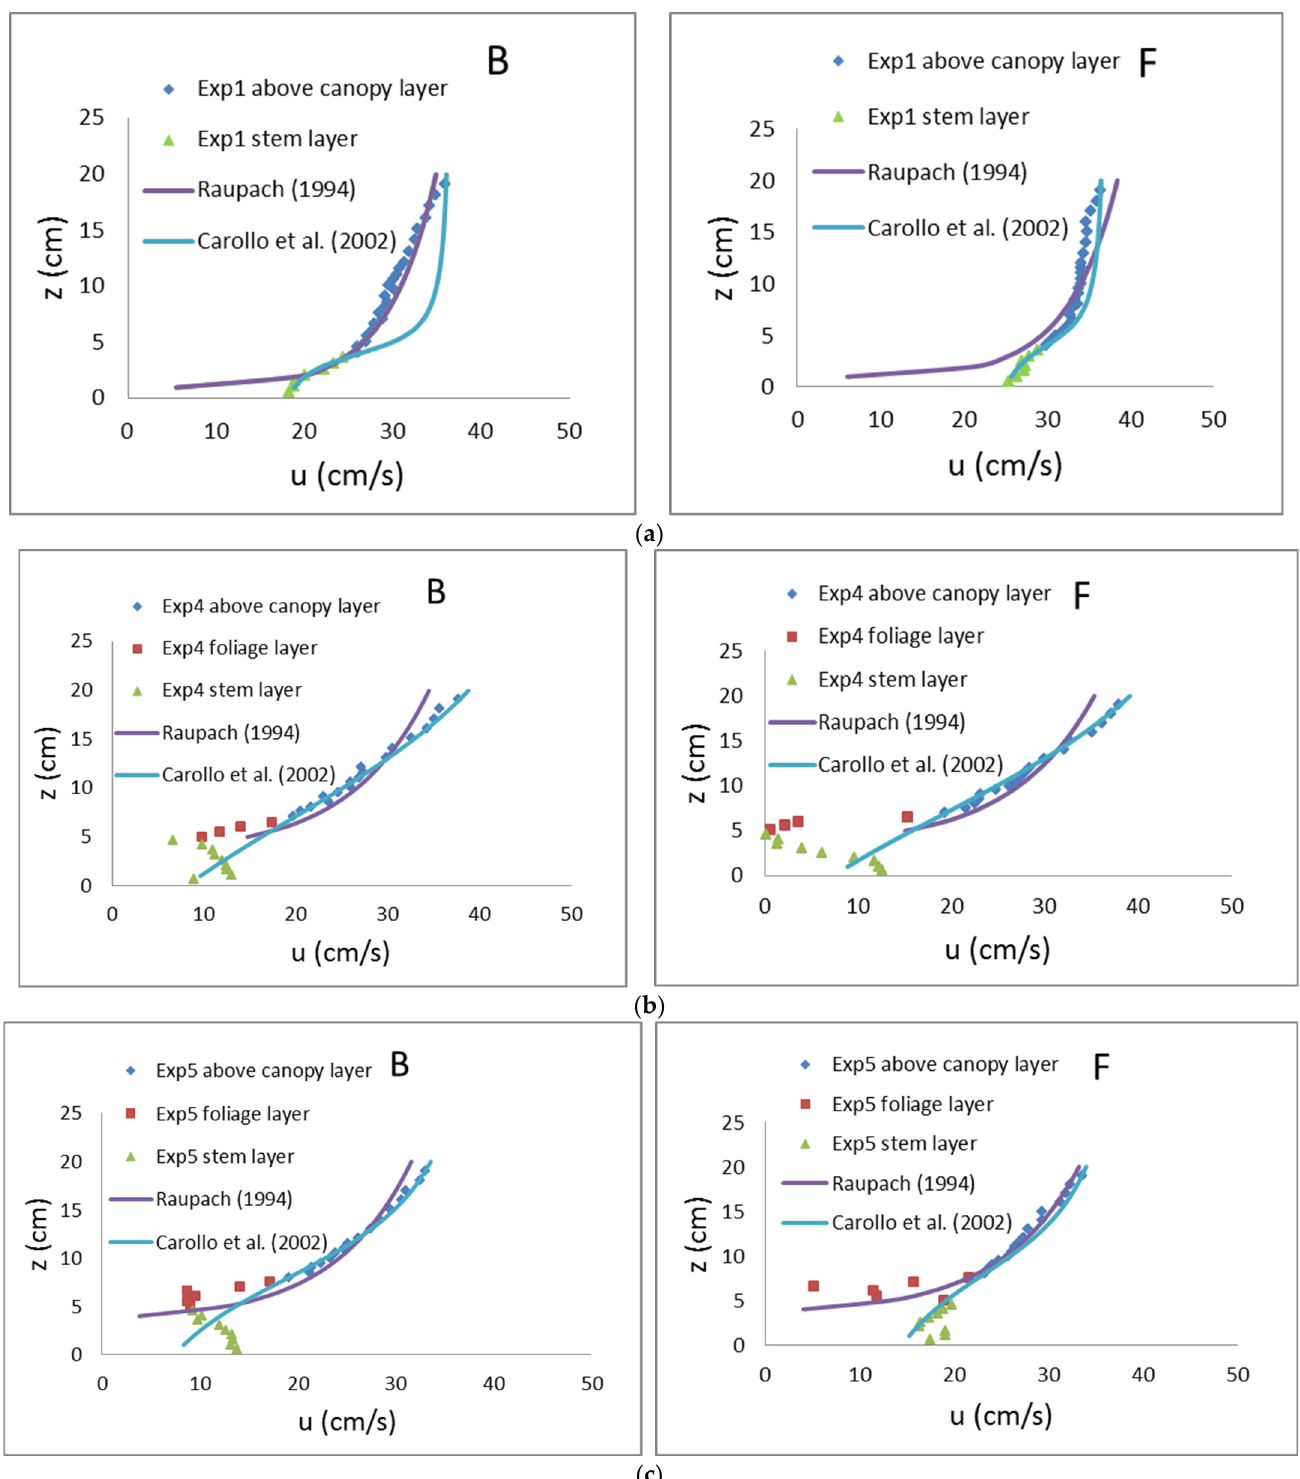
Figure 8. Velocity distribution data at B and F compared to equations of Raupach [19] and Carollo et al. [12] for ( a ) Exp1, ( b ) Exp4 and ( c ) Exp5.